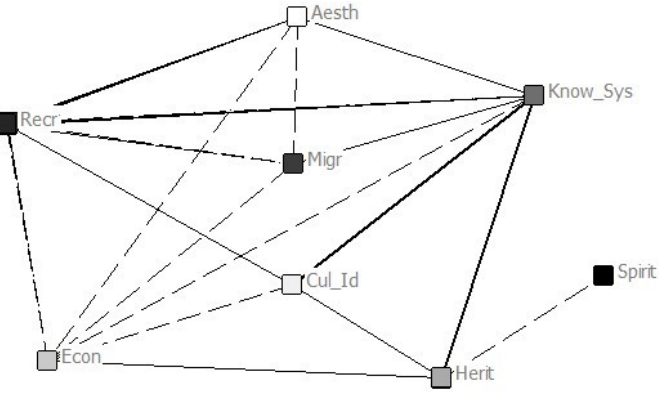
Figure 5. Relations between different CESs according to correlations in the survey. Continuous lines represent a high significance (the correlation is significant at the level of 0.01) and dashed lines a low significance (the correlation is significant at the level of 0.05). Source: Own